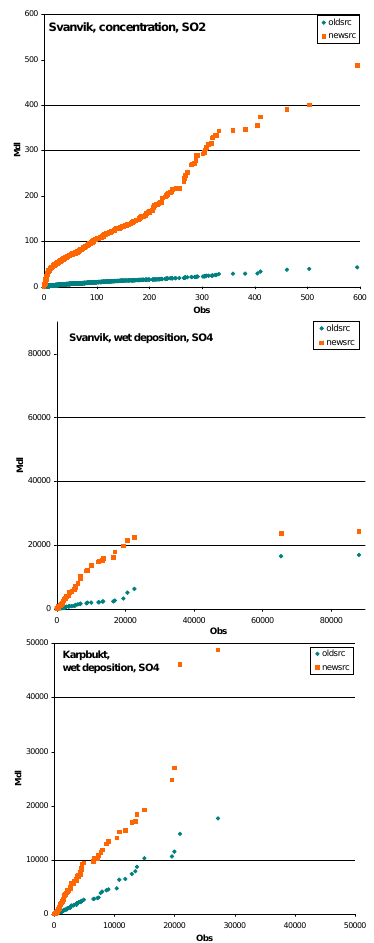
Fig. 9. Quantile charts for SILAM simulations vs. observations at the nearest sites to the Nikel plant. First panel: hourly concentration values in Svanvik [mugSO 2 m − 3 ], second and third panel: weekly wet deposition in Svanvik and Karpbukt [µgSm − 2 week − 1